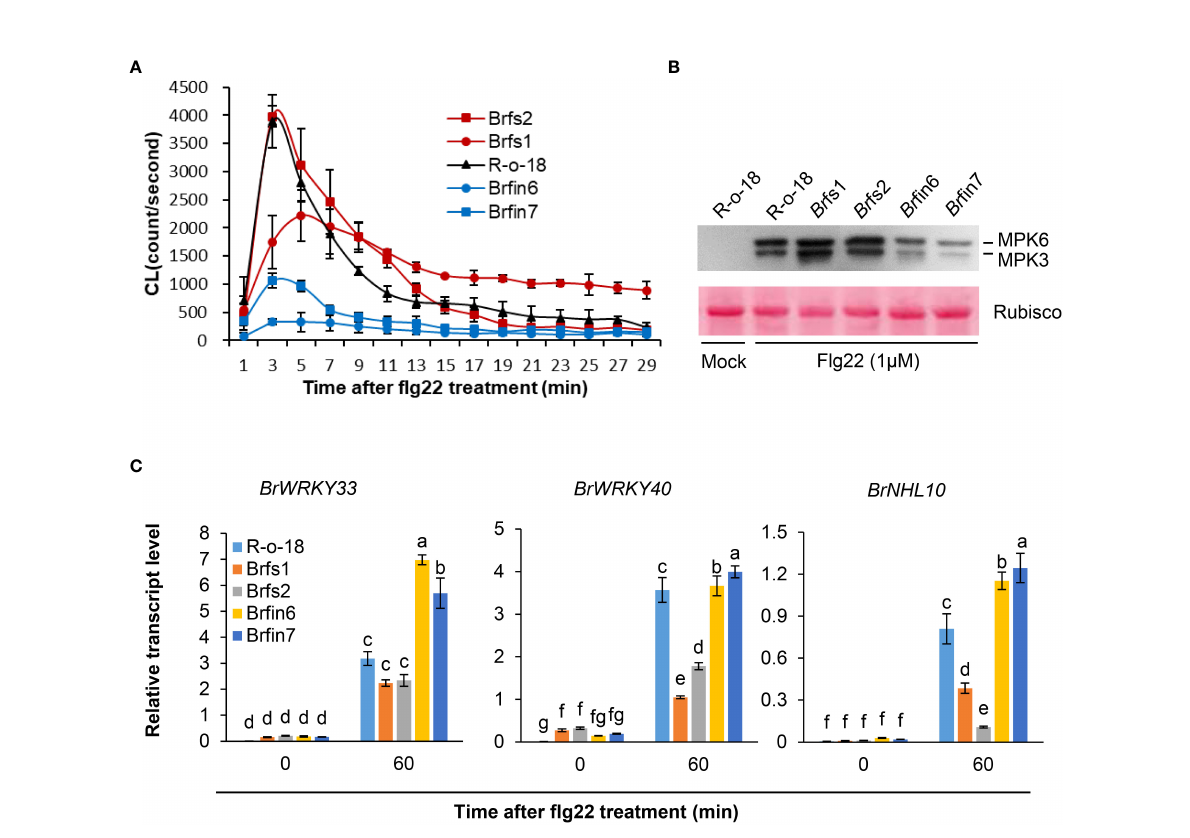
FIGURE 3 Phenotypes of Br fs and Br fi n lines during fl g22-triggered signaling. (A) Flg22-induced ROS generation in liquid-grown intact seedlings of B. rapa inbred lines treated with 1 µM fl g22. Error bars represent standard deviations of 24 independent samples. Similar results were obtained in two